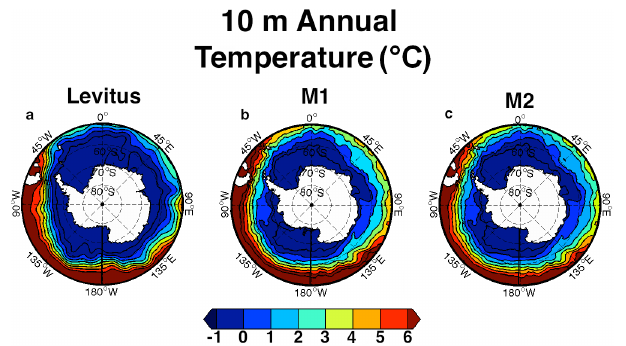
Fig. 4. Near surface (10m) annual mean salinity for (a) Levitus climatology, (b) M1, and (c)